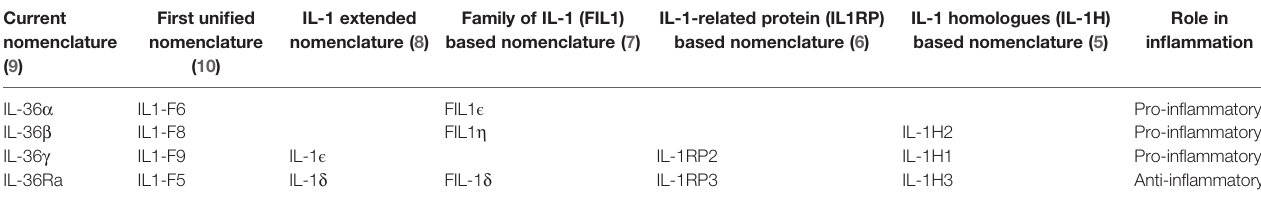
TABLE 1 | Current and former nomenclature of IL-36